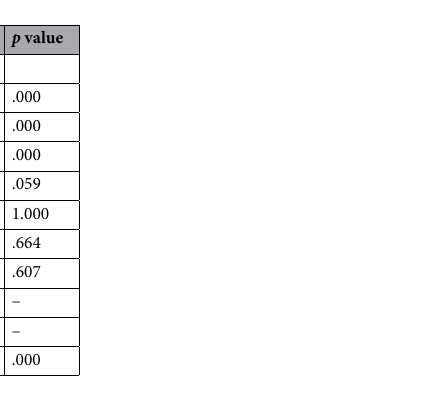
Table 2. Longitudinal changes in shoulders without